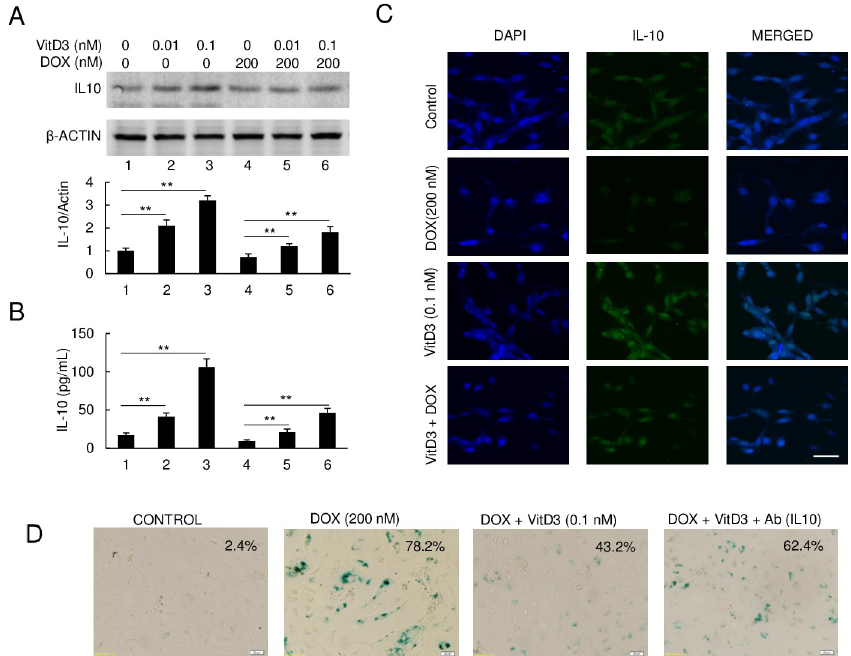
Fig 3. VitD3 upregulates IL-10 expression to attenuate DOX-induced senescence. (A) Immunoblot of IL-10 expression after DOX and VitD3 cotreatment. The bottom panel is the quantified density of protein levels ( �� p < 0.01, n = 3). (B) ELISA measurement of IL-10 levels in the culture media ( �� p < 0.01, n = 3). (C) Fluorescence staining of IL-10 on HAEC cells under VitD3 and DOX cotreatment. IL-10 was stained with FITC-labeled and DAPI was performed for nucleus staining. Scar bar, 10 μ m. (D) IL-10 antibody attenuated VitD3 protection effect.